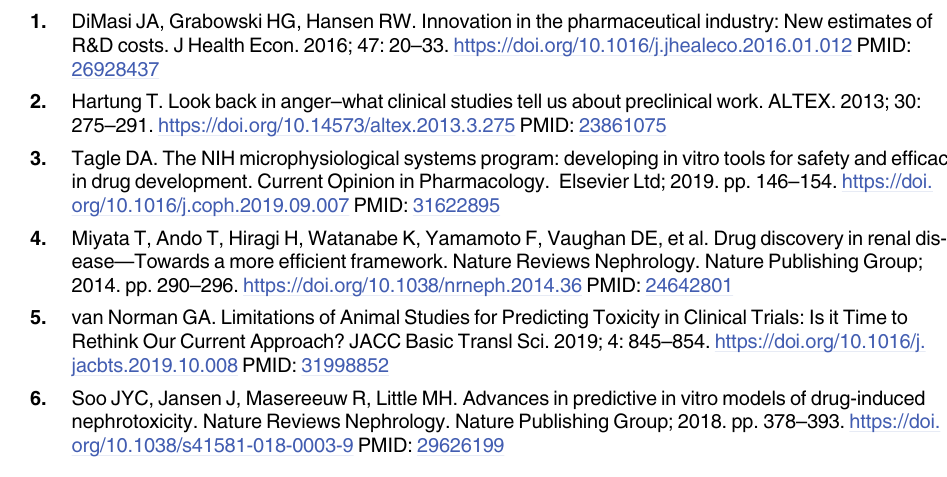
S2 Fig. RPTEC-TERT1 monolayer culture at D10 stained for primary cilia. RPTEC-TERT1 cells demonstrate positive staining for primary cilia, visualized in 3-dimensions shows individ- ual cilium pointed upwards (100 μ m scales). S1 Table. Materials list. S2 Table. Antibody list. S3 Table. 15 marker Luminex panel and